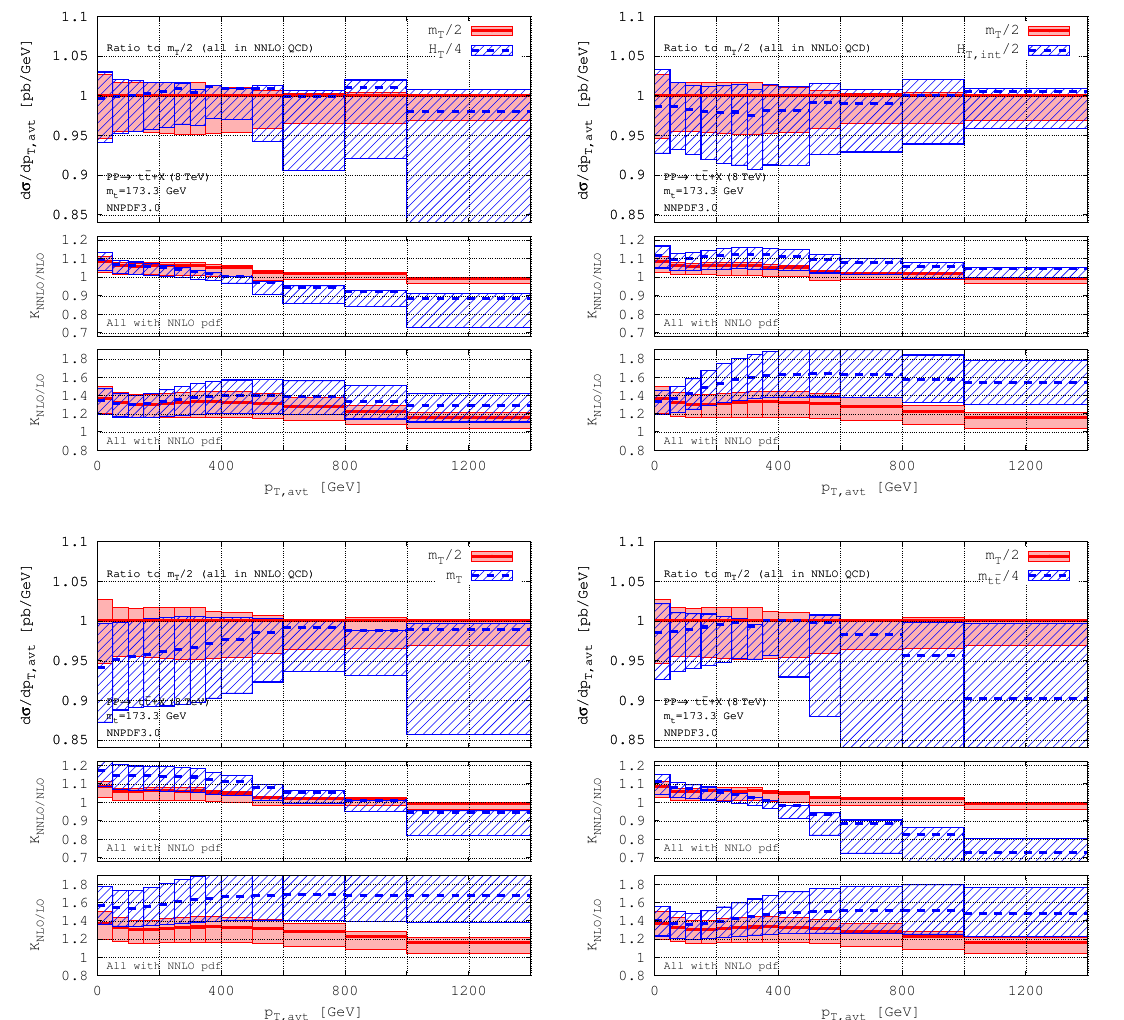
Figure 12 . As in (cid:12)gure 5, but all partonic cross-sections (LO, NLO and NNLO) are computed with NNLO